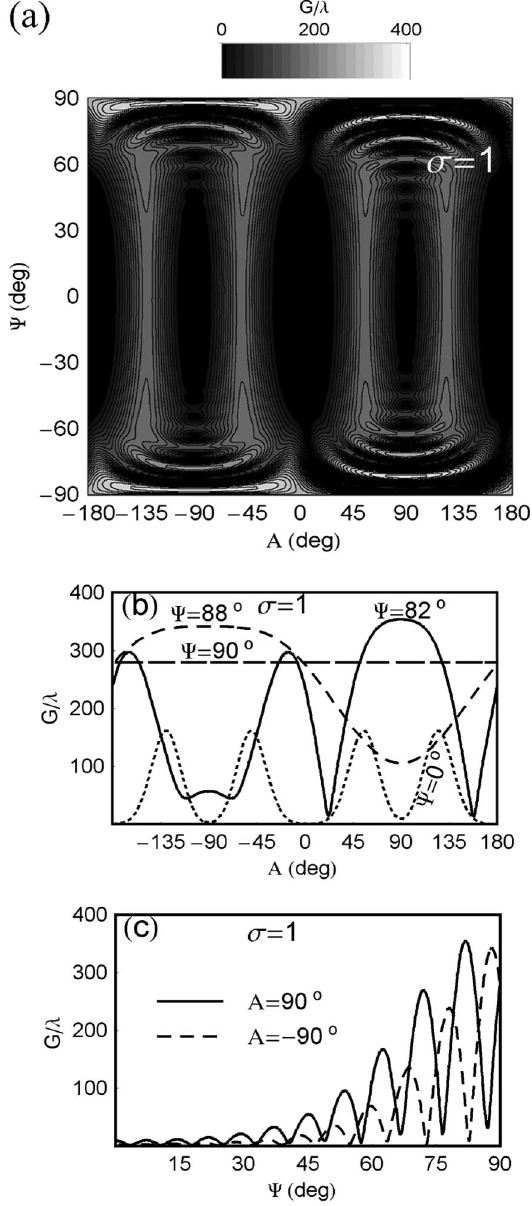
FIG. 6. Gain over (cid:8) as a function of the electron velocity parameters. (a) Contour plot of the gain as a function of A (velocity azimuth) and (cid:5) (cid:2) 90 (cid:14) (cid:4) (cid:3) for (cid:2) (cid:2) 1 (clockwise polarization), l (cid:2) 22 TE resonance. (b) Gain over (cid:8) as a function of the velocity azimuth A for several angles (cid:5) . (c) Gain over (cid:8) as a function of (cid:5) for azimuths A (cid:2) 90 (cid:14) and A (cid:2) (cid:4) 90 (cid:14)